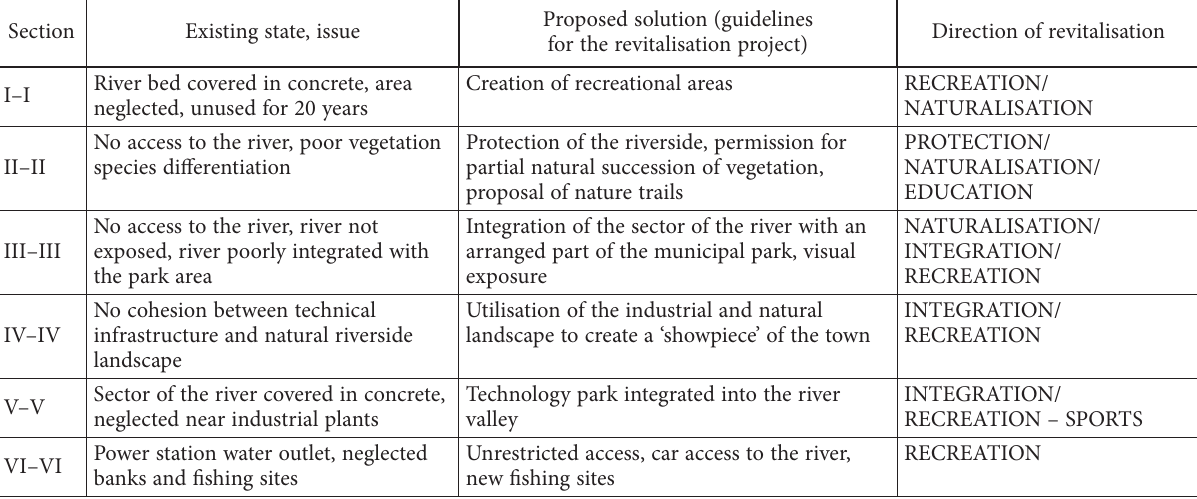
Table 4. Guidelines for a Skawinka river valley revitalisation project according to the LSHM Method (source: author’s study)